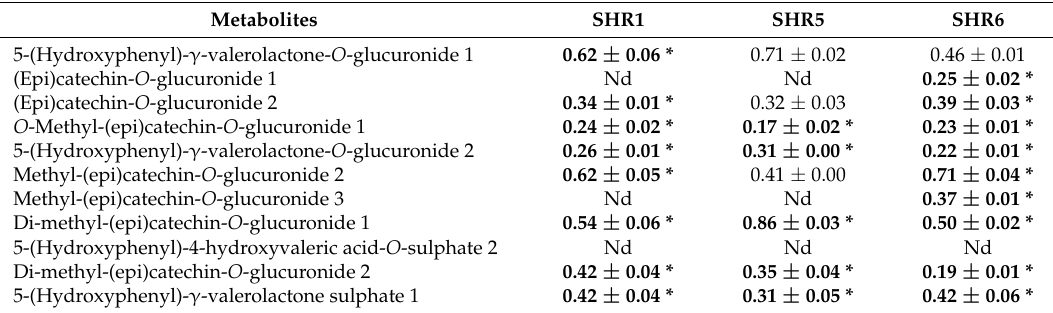
Table 6. Mean plasma metabolite levels at day 7, 4 h after ingestion of grape pomace extracts. Data are expressed as nmol ± SD.